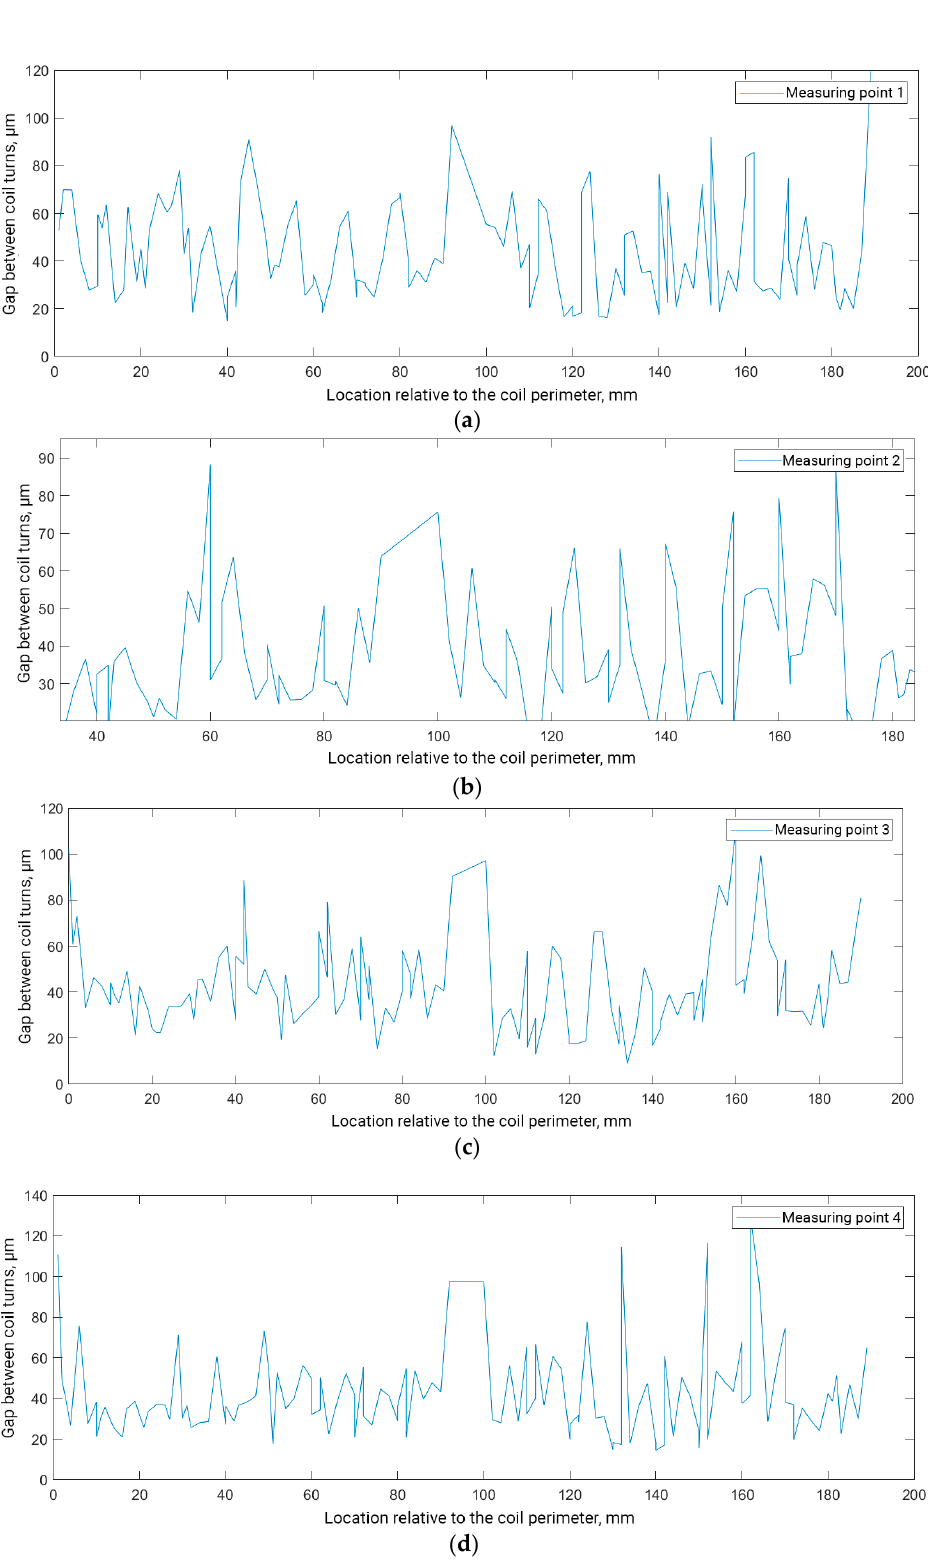
Figure 8. Graphs of gap values between turns for coil No. 1, measured at points 1 ( a ), 2 ( b ), 3 ( c ), 4 ( d ) in accordance with Figure 6.